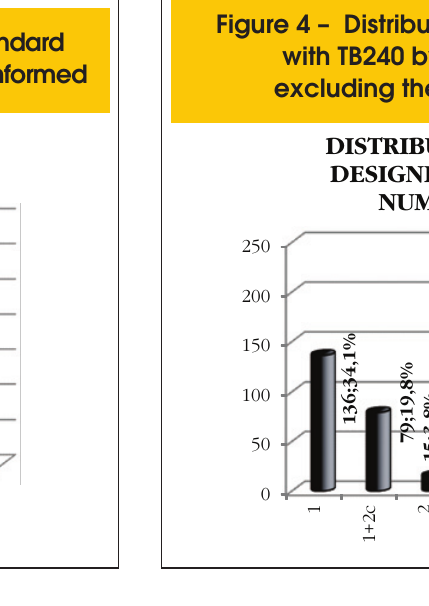
Figure 3 – Distribution of bridges by standard vehicle-load excluding the bridges not informed